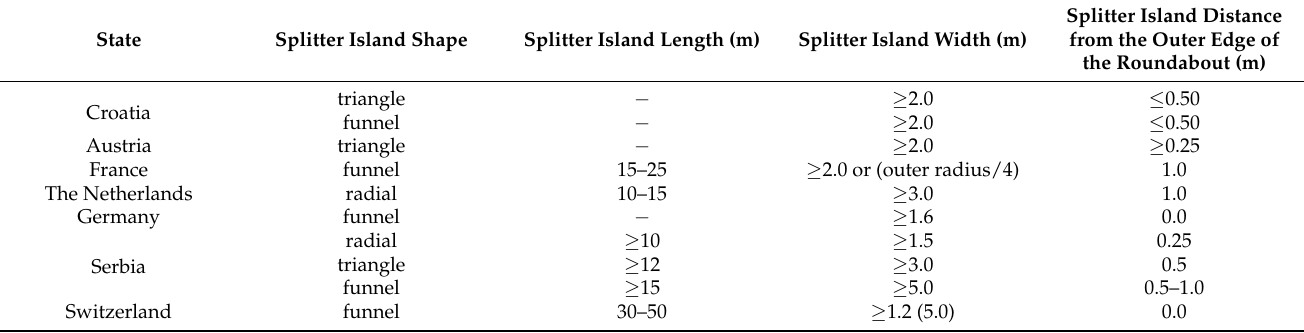
Table 5. Recommended design shape and dimensions of splitter islands according to